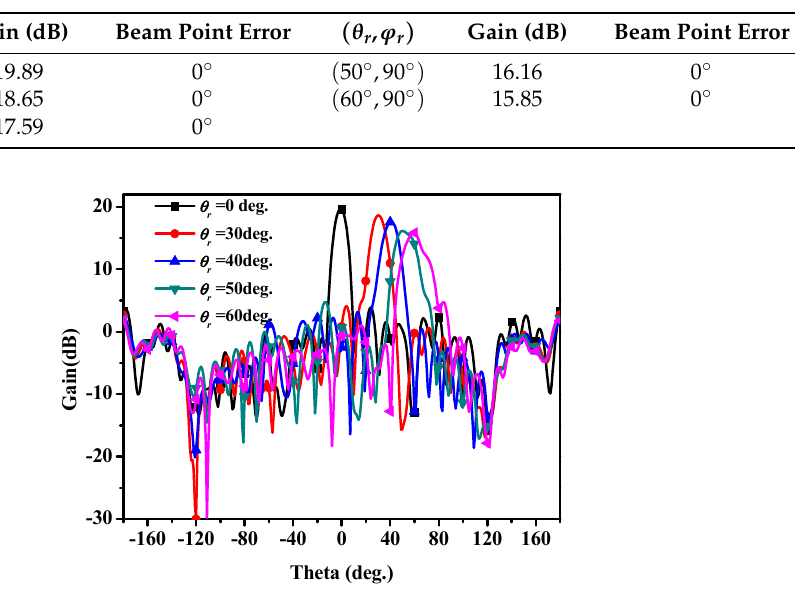
Figure 7. Scanning main beam characteristics of the 1-bit digital RRM.